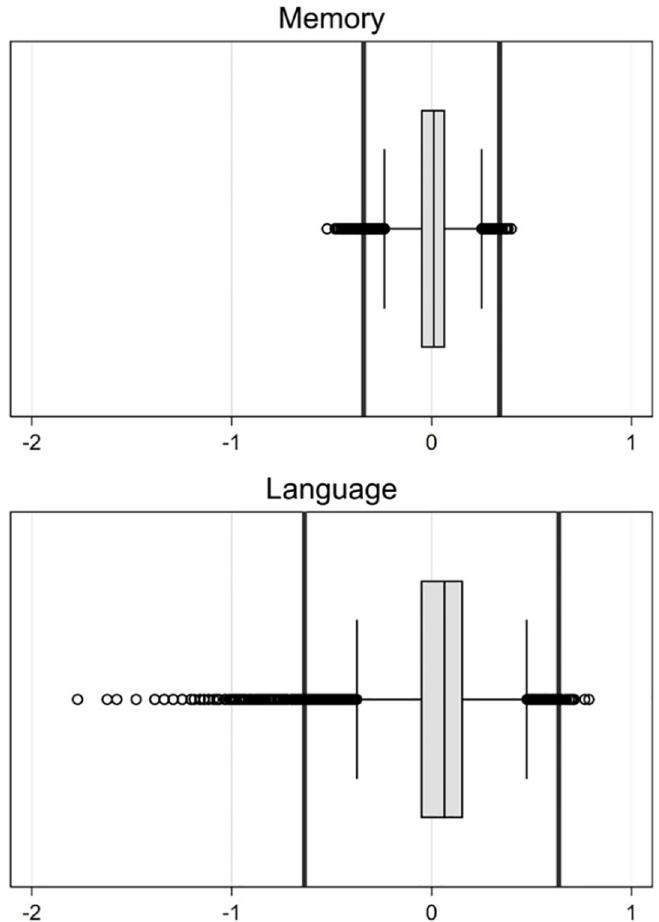
Fig 1. Differential Item Functioning (DIF) impact; the boxplots represent the difference scores of initial and DIF- modified scores per domain and the vertical lines represent 1x the standard error of measurement of the sample, i.e., the threshold for salient